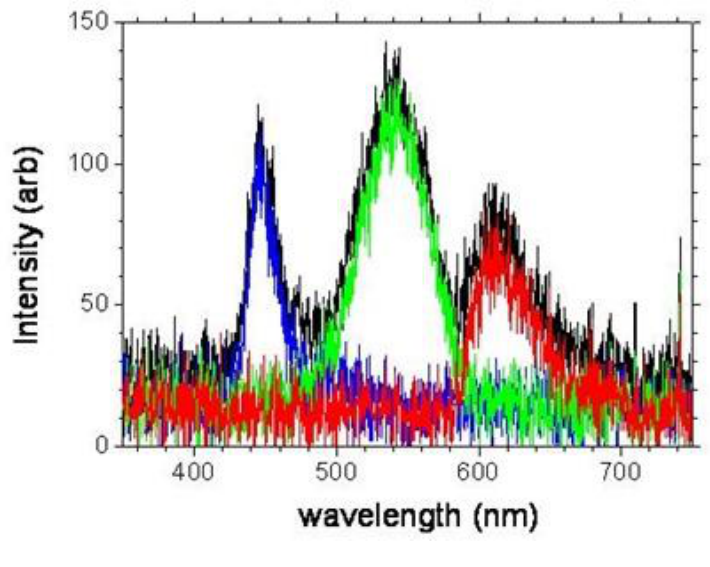
Figure 2. Optical spectra showing the emission from individual RGB OLED and the total spectra when all are